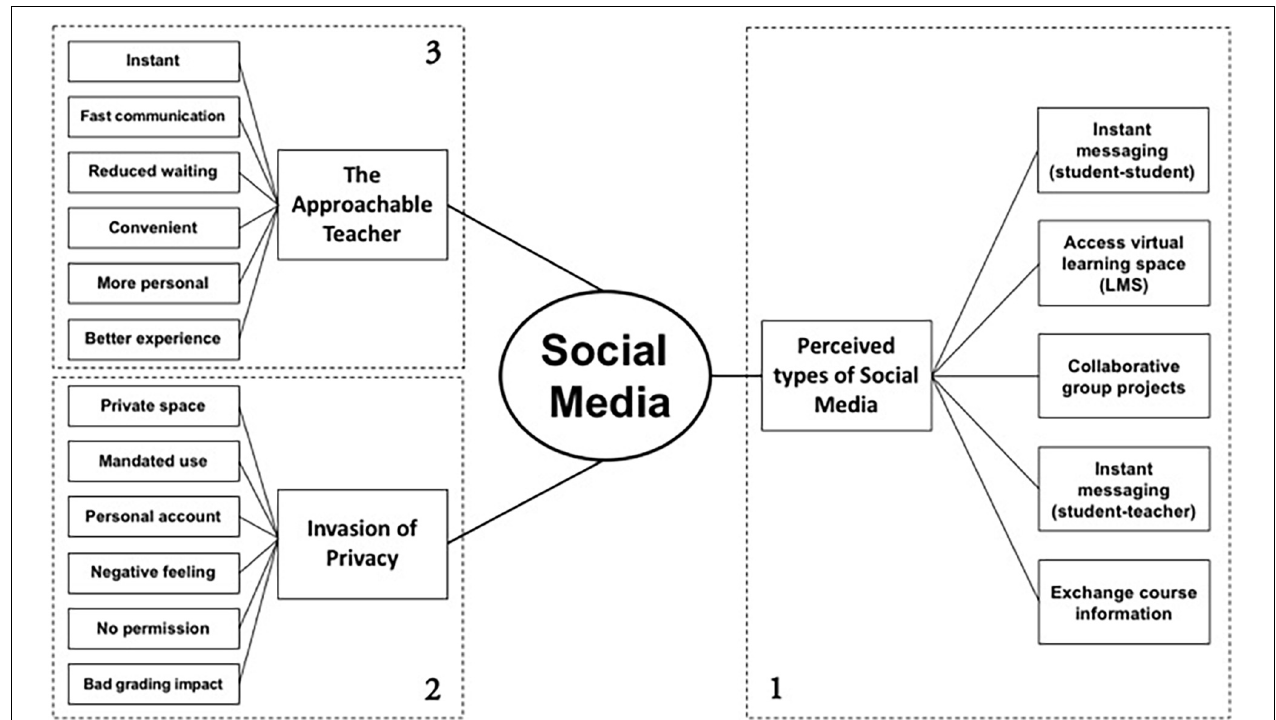
FIGURE 1 | Visualization of the emerged themes and their respective coding (based on empirical